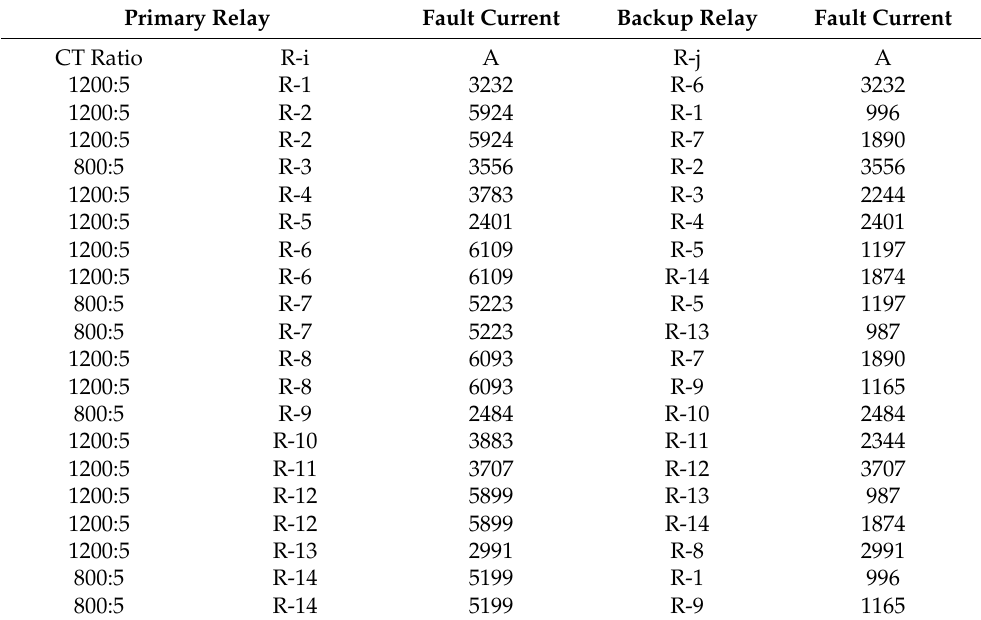
Table 3. Fault currents data and primary-backup relays.